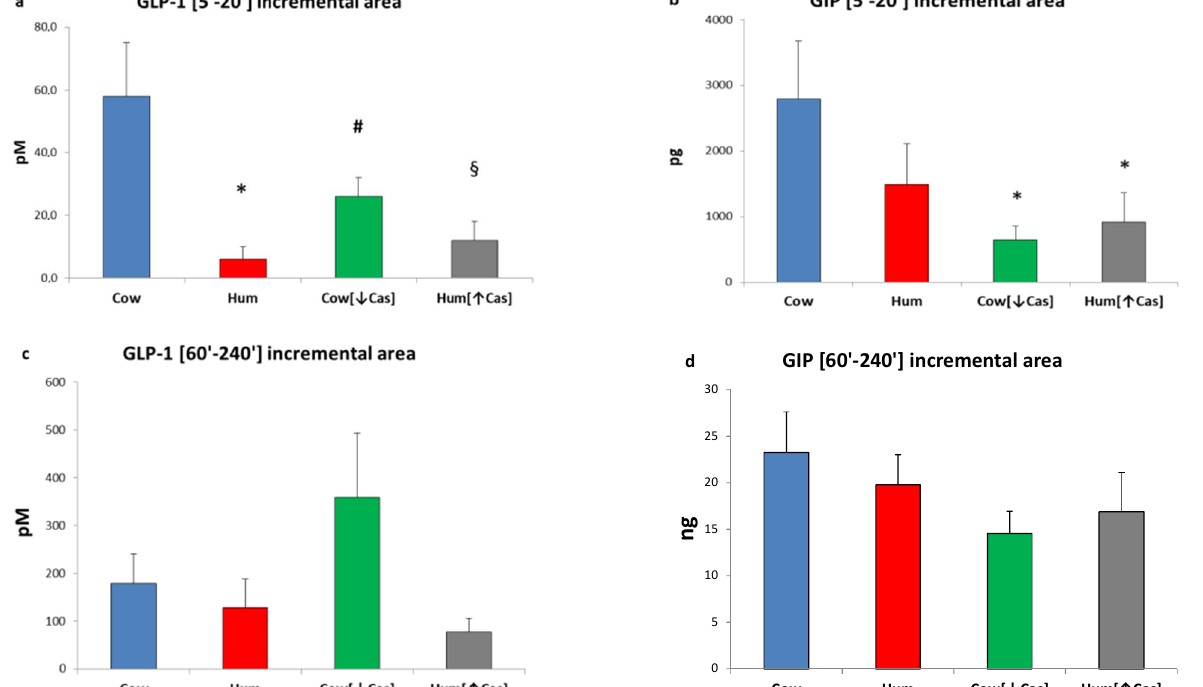
Figure 4. GLP-1 and GIP incremental areas. Abbreviations: GIP: glucose-inhibitory-polypeptide;